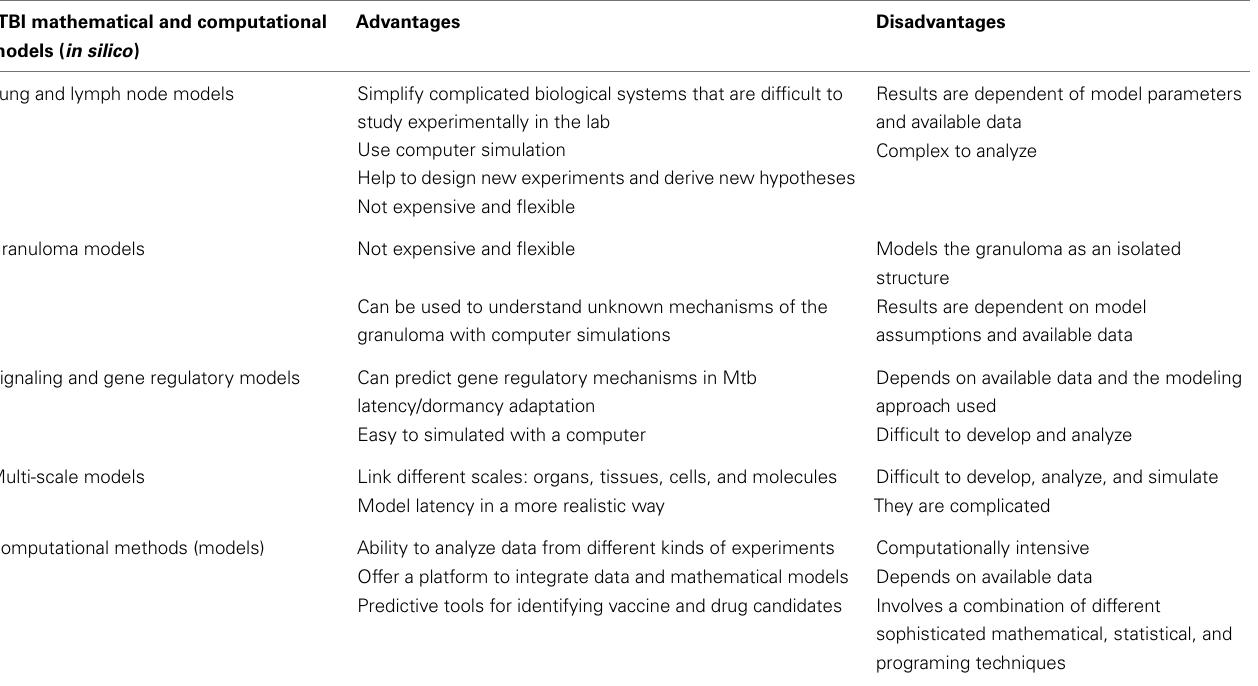
Table 1 | LTBI mathematical and computational